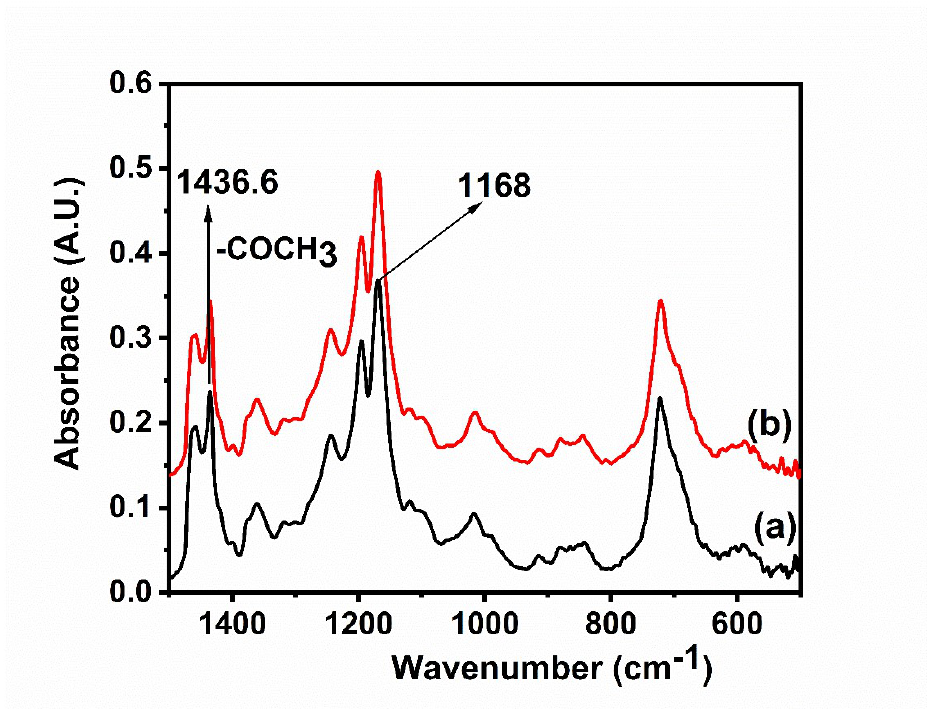
Figure 13. FT-IR spectra of biodiesel obtained with ( a ) refined cooking oil and ( b ) waste cooking oil.